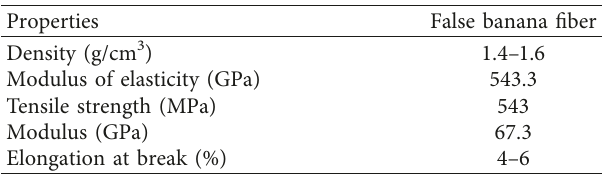
Table 1: Physical and mechanical properties of false banana fiber